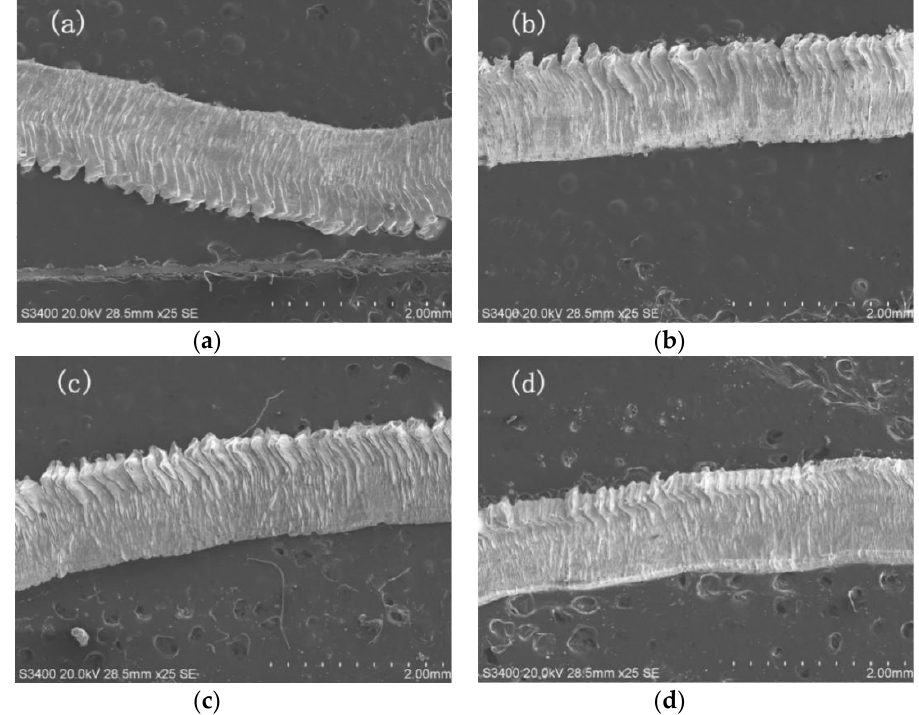
Figure 5. The free surface of the chips produced by the four tools. ( a ) Produced by a non-textured tool; ( b ) Produced by a line textured tool; ( c ) Produced by a sinusoidal textured tool; ( d ) Produced by a rhombic textured tool.